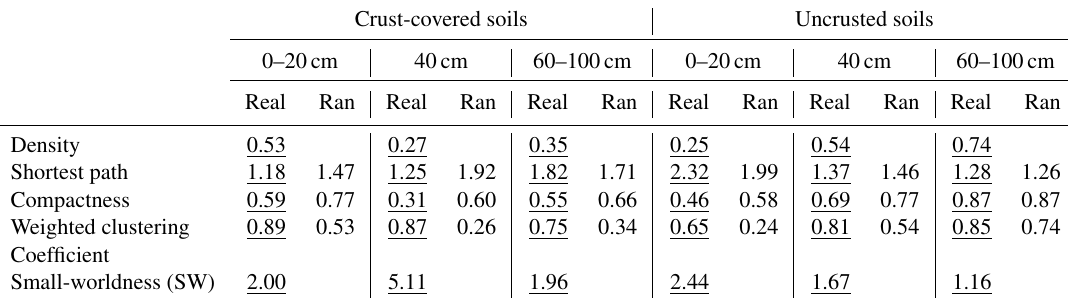
Table 4. Values of certain global metrics estimated for the network of interactions between individual PLFAs under two crust coverage regimes at successive distances from the trunk to the periphery of Erica spp. shrubs. Comparisons of metrics with those produced by random networks with the same number of ties and nodes are also presented. In all cases the differences between real (underlined values) and random (Ran) networks were significant, with the exception of average distance and compactness estimated for uncrusted soils at a distance of